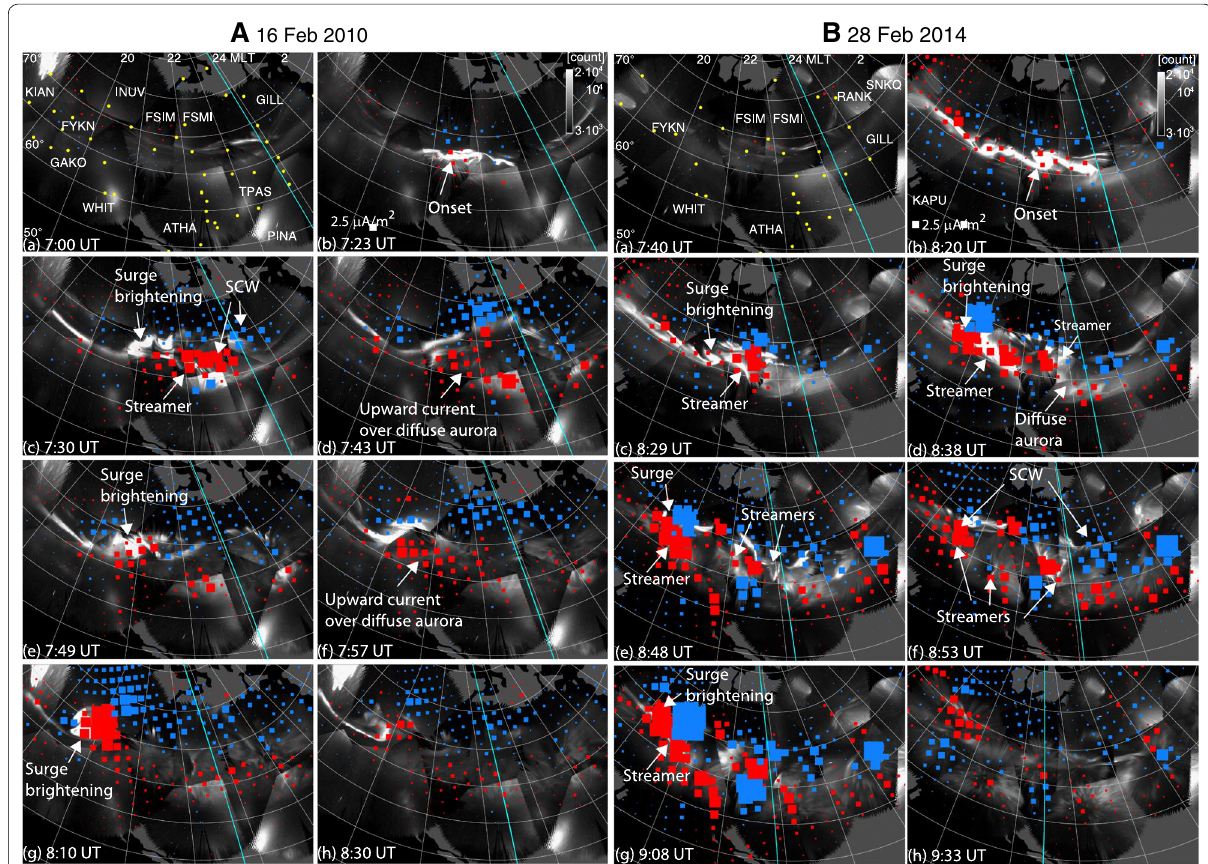
Fig. 3 Selected images of upward (red) and downward (blue) currents overlaid onto ASI data (grayscale) for the ( A ) 16 February 2010 and ( B ) 28 February 2014 event. The light-blue line marks magnetic midnight. The latitude and longitude contours are given every 5° and 15°. Magnetometer locations are marked by yellow dots in Panel a. The whole sequence is given in Additional files 1 and